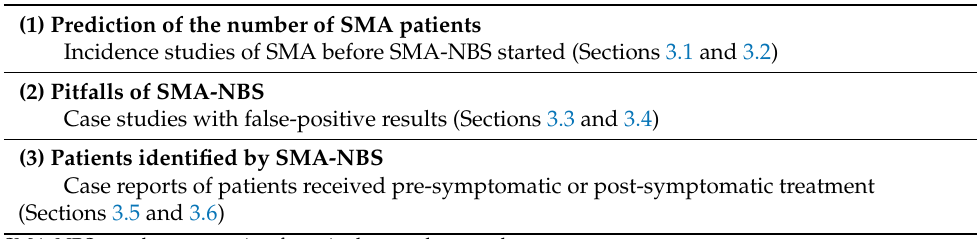
Table 1. Studies related to SMA-NBS in Hyogo Prefecture.